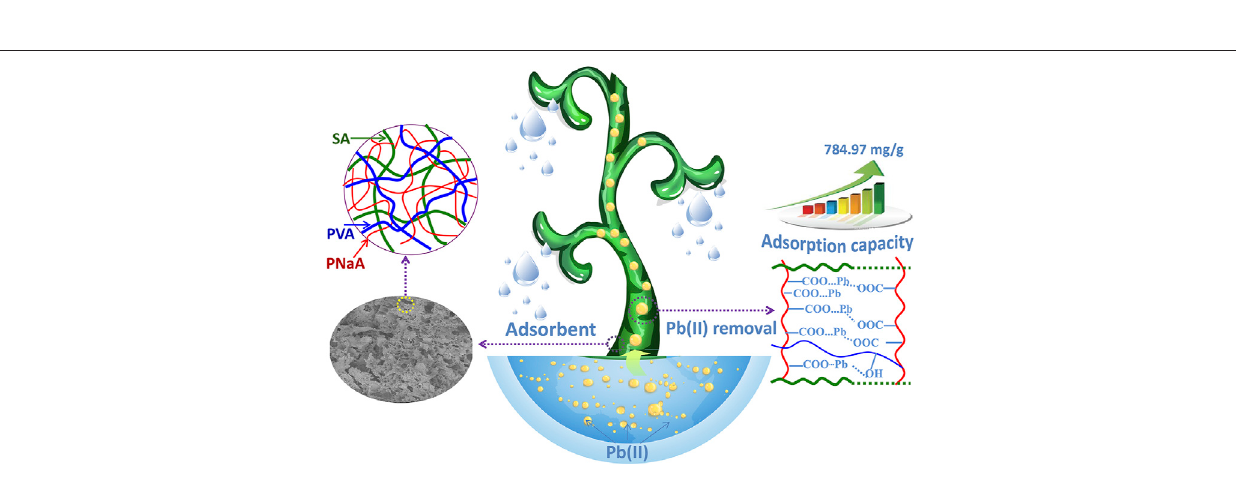
Frontiers in Chemistry |